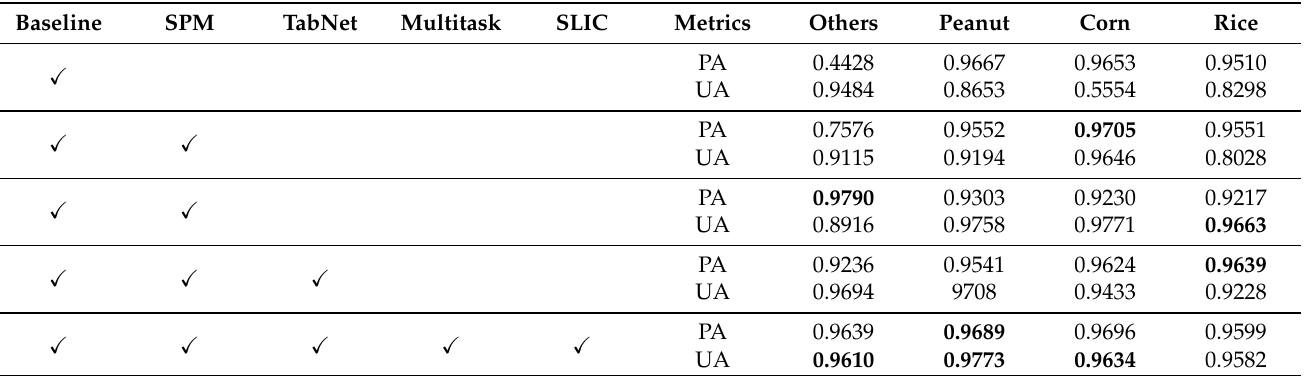
Table 7. Ablation experiments for the network design evaluate in the PA and UA values. The optimal accuracy is